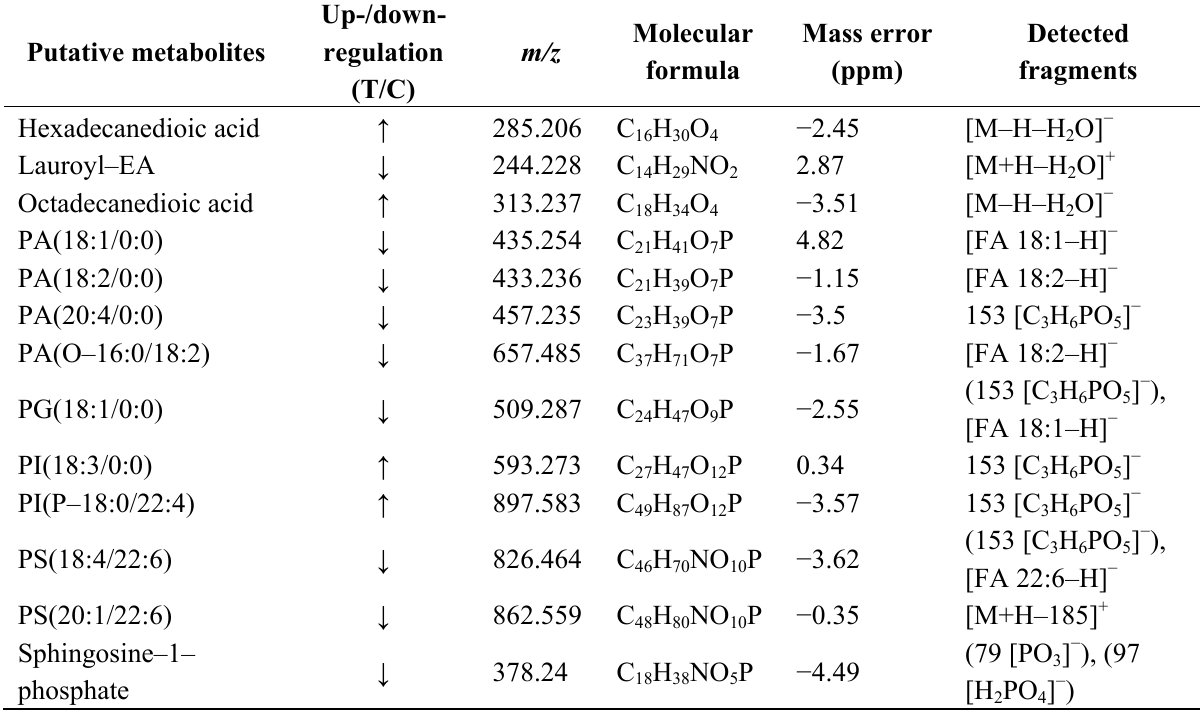
Table 1. Differential lipids in control vs. treated groups. Metabolites with